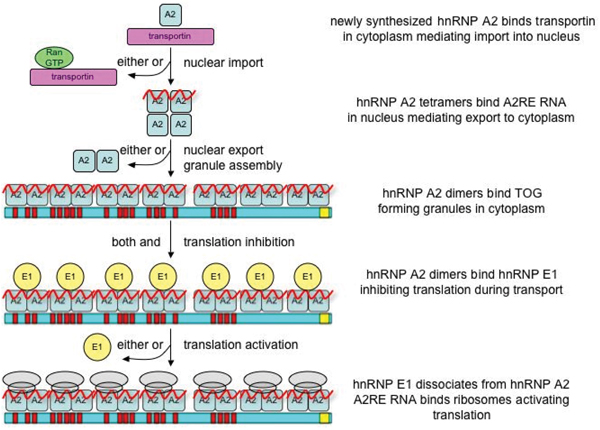
Sequential molecular interactions in the A2 pathway. Molecular interactions associated with sequential steps in the A2 pathway are illustrated. In the first step, newly synthesized hnRNP A2 binds to transportin in the cytoplasm and is imported into the nucleus. In the nucleus, transportin binds either RanGTP or hnRNP A2 and hnRNP A2 binds either A2RE RNA or tansportin. In the next step, hnRNP A2 oligomers bind to A2RE RNA in the nucleus and are exported to the cytoplasm. In the cytoplasm, hnRNP A2 dimers bind either to other hnRNP A2 dimers or to TOG protein, which mediates granule assembly. In the next step, hnRNP A2 binds both TOG protein and hnRNP E1, which inhibits translation during transport. In the last step, granules bind either hnRNP E1 or ribosomal subunits, to initiate translation. Steps involving either or interactions are essentially irreversible and promote polarity to the pathway. Steps involving both and interactions are reversible.